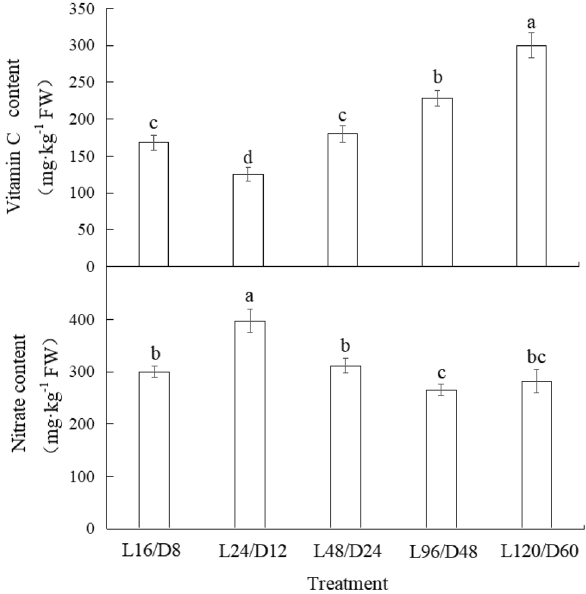
Figure 8. The contents of Vitamin C and nitrate of lettuce exposed to different L/D cycle treatments of RB. Different letters for the same parameter indicate significant differences at the 5% level, according to the Tukey’s test (n = 3). The bars represent the standard errors. L/D—light/dark. L16/D8—16 h light/8 h dark (as control), L24/D12—24 h light/12 h dark, L48/D24—48 h light/24 h dark, L96/D48—96 h light/48 h dark, L120/D60— 120 h light/60 h